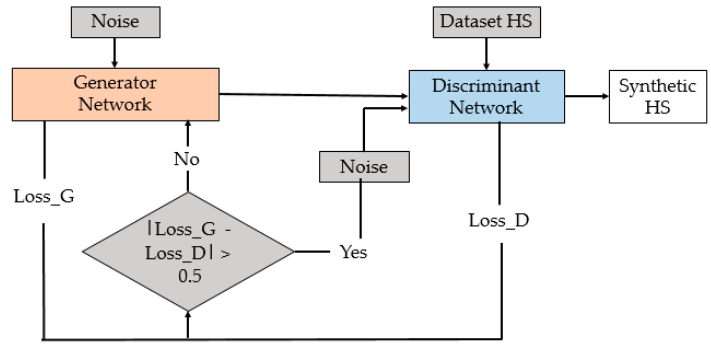
Figure 4. Proposed GAN diagram.